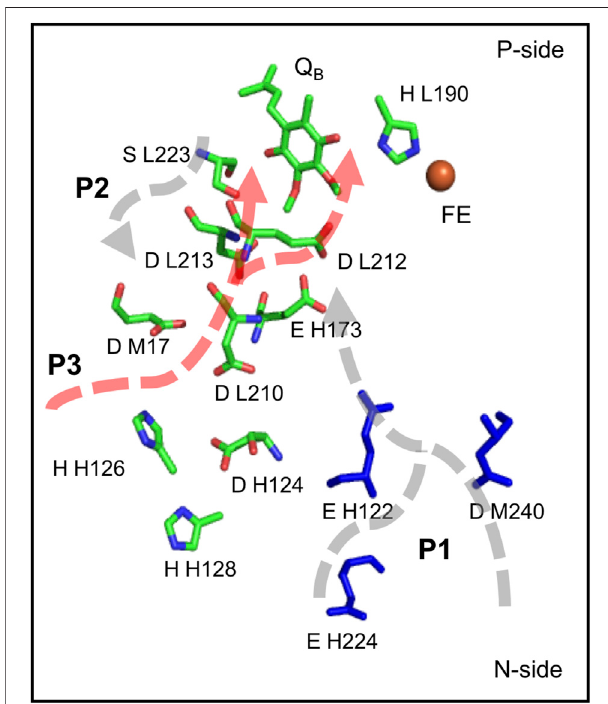
FIGURE 7 | Three proposed paths for the two protons from the surface to the Q B site (Abresch et al., 1998), showing key residues on each path including H-His 126, H-His 128, H-Asp 124, L-Asp 210, M-Asp 17, H-Glu 173, L-Asp 213, L-Ser 223 and L-Glu 212 (Okamura et al., 2000; Paddock et al., 2003; Wraight, 2004). Coordinates from Rb. sphaeroides bRCs PDB ID: